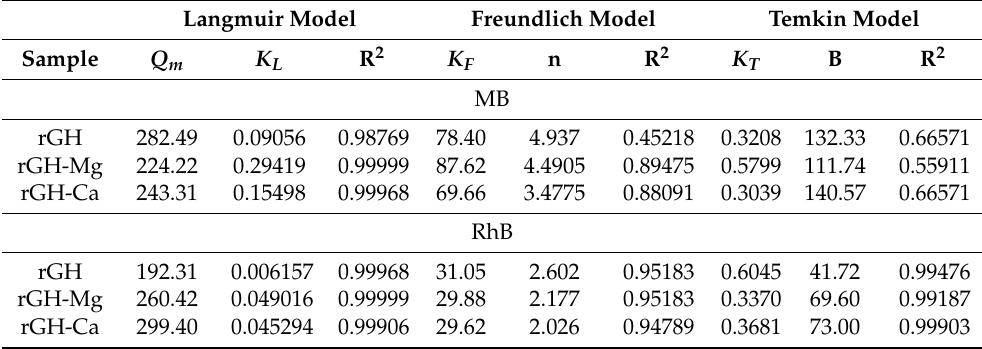
Table 6. Langmuir, Freundlich, and Temkin equilibrium isotherm constant for the adsorption of MB and RhB.